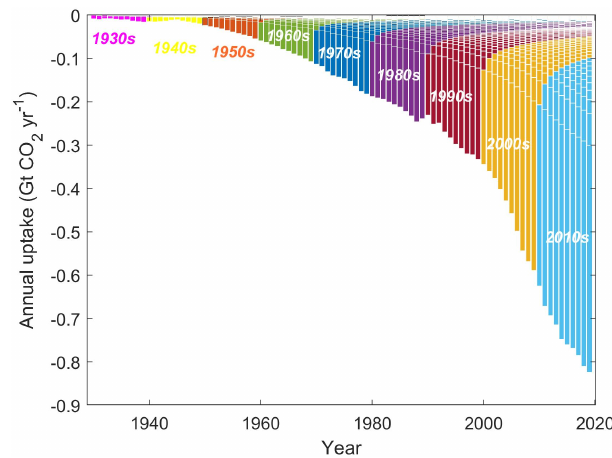
Figure 7. The cumulative characteristic of carbon uptake of ce- ment. The colour-coded bar areas represent the amount of uptake by the cement produced/consumed in each decade from 1930 to 2019. The fractions of uptake that occurred in each decade post-1990 are annotated. The “tails” indicate that cement produced in a certain time will keep absorbing CO 2 beyond its production or consump- tion, and the annual uptakes are composed of current and historical contributions.